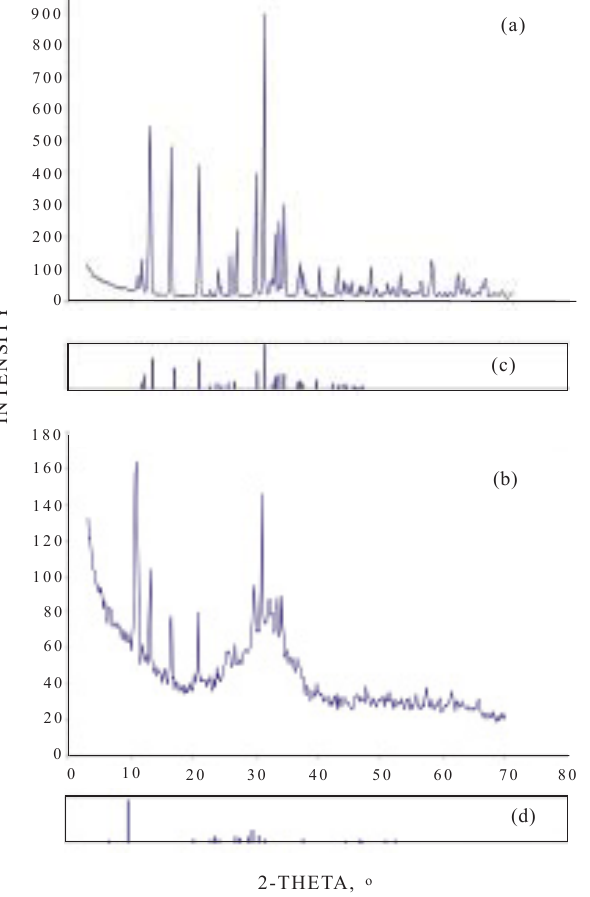
Figure 6. X ray diffractogram and powder diffraction file (PDF) data of the residues remaining in the filter paper after filtration of the solution of NaCl 0.01 mol L -1 with pH 5 (original compounds: a = H8-syn, b = H14-syn; PDF file: c = H8, d =